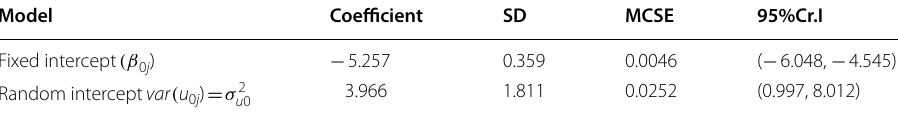
Table 2 Bayesian multilevel logistic regression of empty model